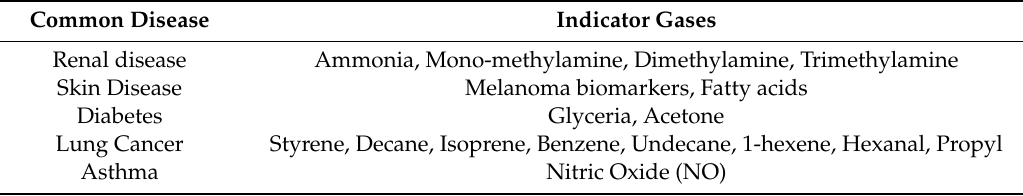
Table 1. Several diseases and the corresponding indicator